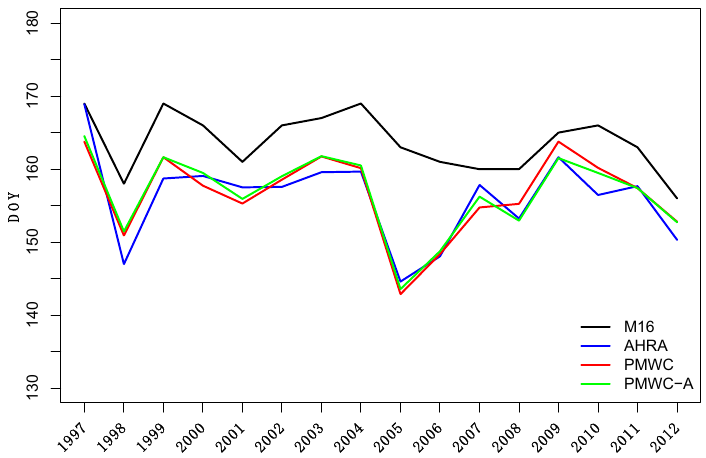
Figure 9. Mean MO dates for the Canadian Arctic Archipelago region (Figure 1) north of 75°N from the Mahmud et al. [19] RADARSAT method (M16) and the passive microwave AHRA, PMWC, and PMWC-A methods (1997–2012).